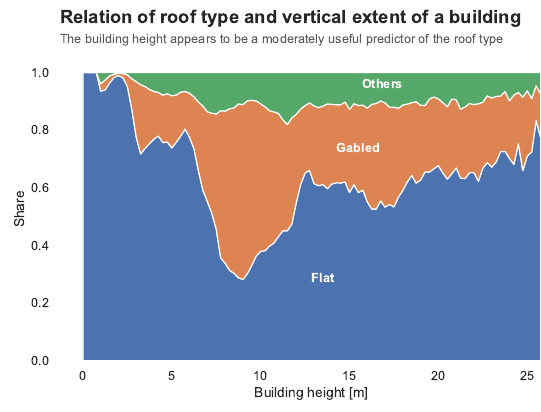
Figure 9. Share of roof types by